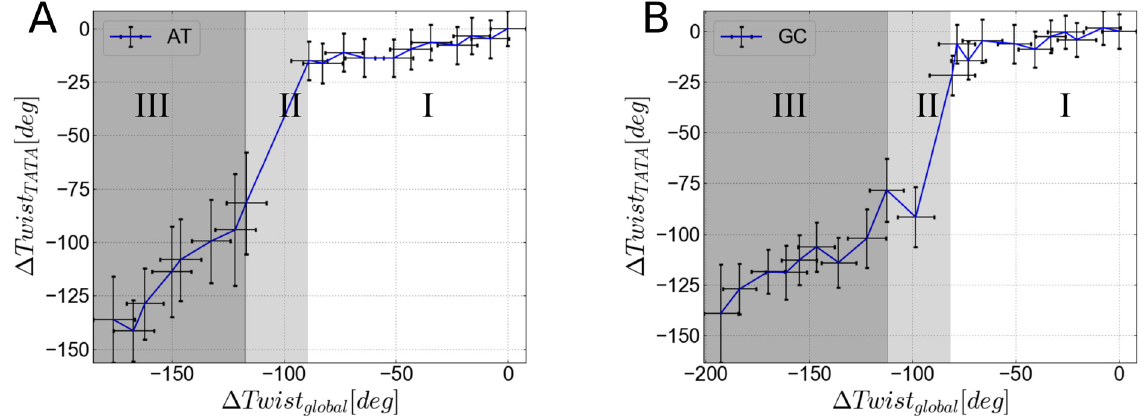
Fig 6. Change in total twist in the TATA box segment upon global unwinding for the at-sequence (A) and gc-sequence (B). In the regime I (harmonic regime) a continuous unwinding is observed that changes abruptly during the melting phase (regime II). During this phase- transition global unwinding is largely stored in the TATA-box segment. Further unwinding causes continuous unwinding of the TATA-Box (regime III) with a steeper slope than in regime I (due to the much smaller twist persistence length of melted vs. intact DNA). Global twisting and twisting of the TATA-Box segment have been computed with a protocol described in chapter 5 in S1 File (same as in Table 2).